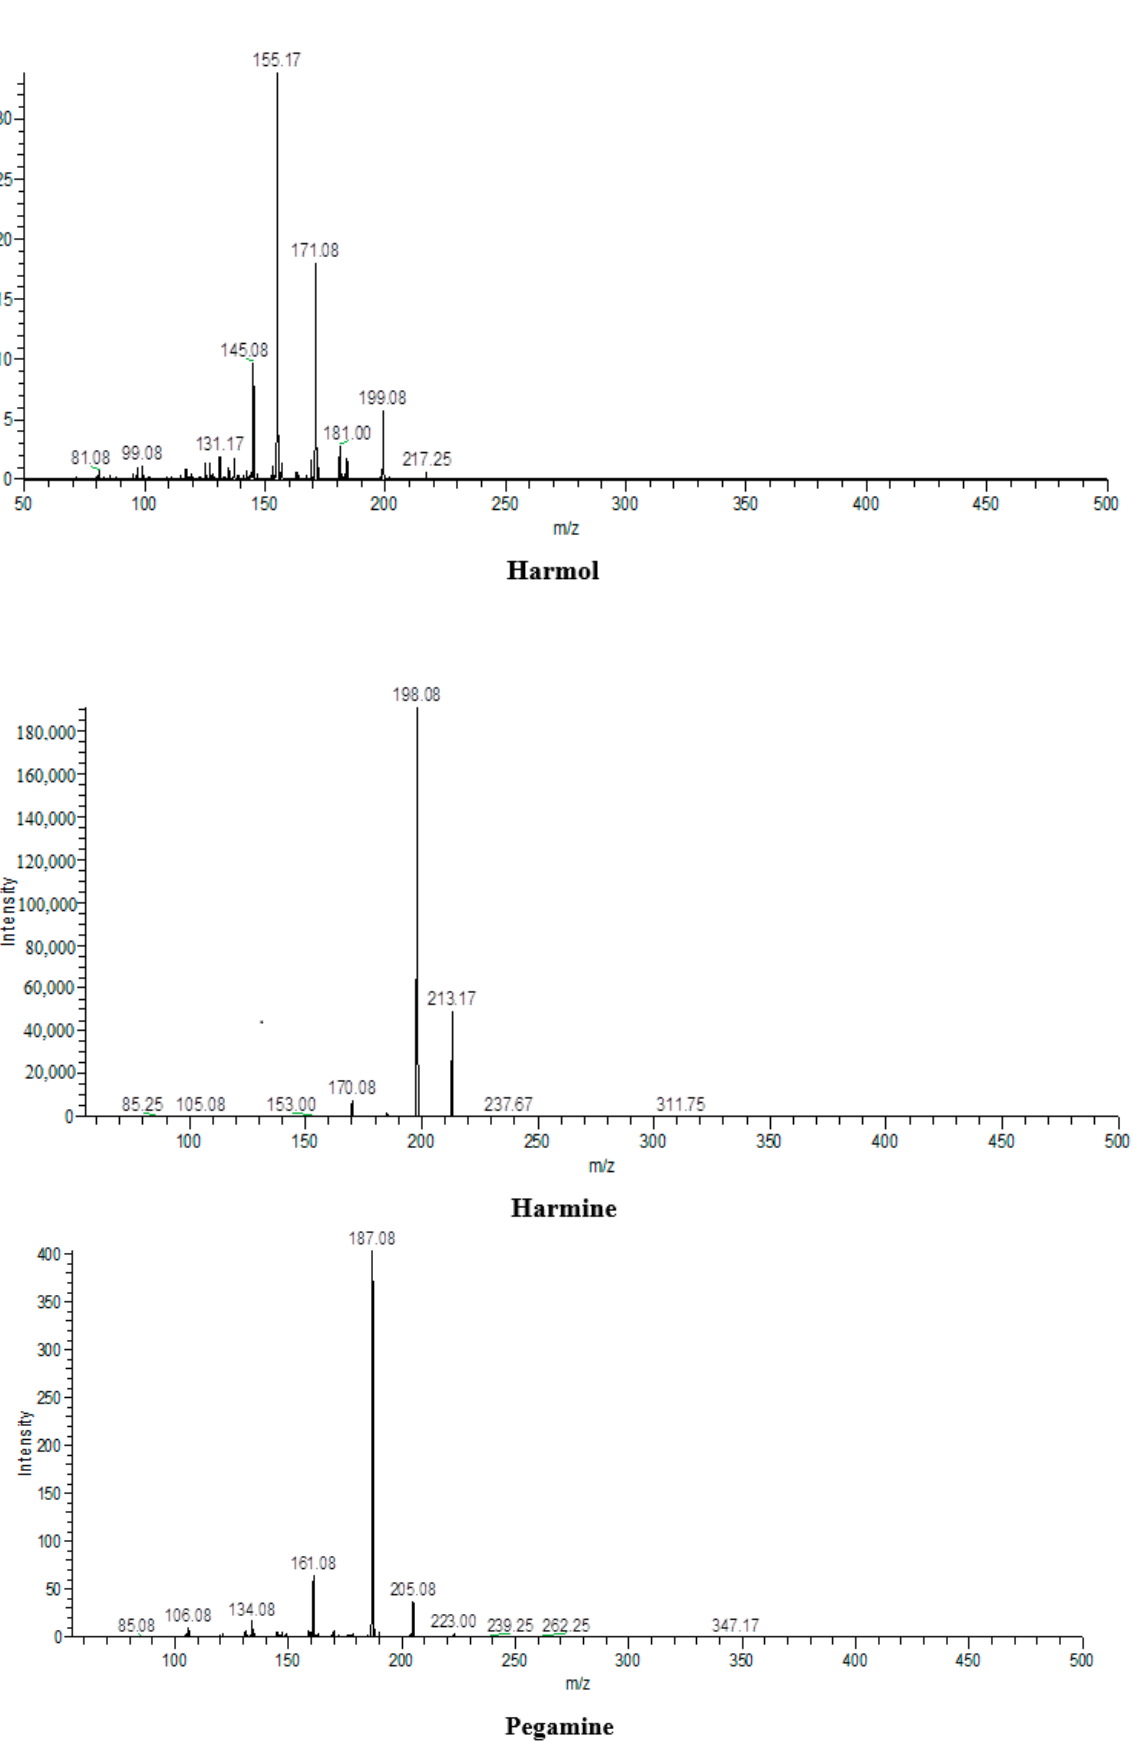
RP-HPLC subfraction PHMF2 was subjected to chromatographic investigation to fur- ther confirm and quantify the compounds identified based on mass spectroscopy using external standards (Table 5). External standards of quinic acid, peganine, harmol, harma- line, and harmine were well separated with our methodology, and eluted at retention times of 9.1, 10.1, 14, 21.8, 22.8, and 23.3 min at 280 nm as shown in Figure 7. Likewise, all these compounds were well separated from PHMF2 at the same retention times and wave- length, and quantified as 6.34, 19.2, 1.3, 3.9, and 53.9 µg/mg, respectively (Figure 8). There- fore, identities of these compounds were confirmed by comparing their retention times and mass spectral data with those of commercially available authentic samples as evident from HPLC overlay chromatograms (Figure 9). In this respect, Herraiz and coworkers re- ported a detectable amount of harmol, harmaline, and harmine as 0.03, 56, and 43.2 mg/g, respectively, from the P. harmala seed methanol extract [60]. On the other hand, the P. harmala methanol root extract also showed the presence of considerable amounts of har- mol (14.1 mg/g) and harmine (20.6 mg/g), whereas harmaline was not detected. Other re- search groups indicated that harmol, harmaline, and harmine were present in the amounts 874, 488, and, 380 µg/mL, respectively, in the P. harmala methanol seeds extract [8]. More- over, peganine was also identified and quantified earlier in the amounts of 9.6, 5.4, 21.2, 19.5, and 10.9 mg/g, respectively, from dry seeds, green fruits, immature fruits, flowers, and leaves of P. harmala [61]. In light of this, more work is required to identify and quantify more biologically active compounds from this traditionally important medicinal plant.